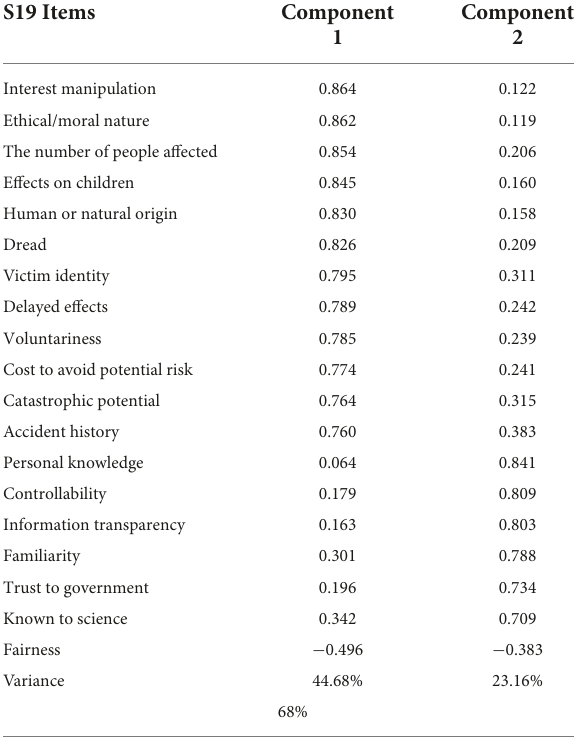
Rotation method: Varimax with Kaiser Normalization. Rotation converged in